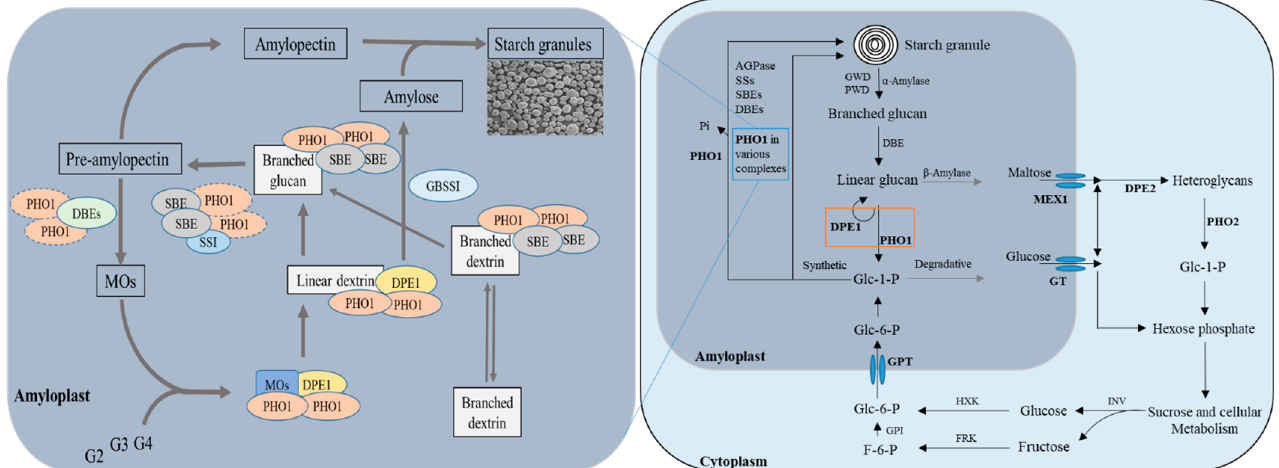
Figure 1. Putative roles of PHO1 and PHO2 in starch biosynthesis and degradation in the non-photosynthetic cell. Abbre- viations: GWD: glucan water dikinase, PWD: phospho-glucan water dikinase, DBE: debranching enzyme, DPE1, plastidial disproportionating enzyme, PHO1, plastidial starch phosphorylase, AGPase: ADP-Glc pyrophosphorylase, SSs: starch synthases, SBEs: starch branching enzymes, DPE2: cytosolic disproportionating enzymes, PHO2: cytosolic starch phos- phorylase, INV: invertase, HXK: hexose kinase, FRK: fructose kinase, GPI: glucose-6-phosphate isomerase, GT: glucose transporter, MEX1: maltose transporter, GPT: glucose-6-phosphate transporter, Pi: inorganic phosphate, Glc-1-P: glucose- 1-phosphate, Glc-6-P: glucose-6-phoshphate, F-6-P: fructose-6-phosphate and MOs: malto oligosaccharide, G2: maltose, G3: maltotriose, and G4: maltotetraose. The orange box indicates the concerted action of DPE1 and PHO1, which might define the fate of the metabolites. The trimmed MOs that are generated by the action of DBEs and PHO1 and branched oligosaccharides enter the starch biosynthetic pathway together, where they are first elongated by the concerted action of DPE1 and PHO1 metabolon, followed by the further elongation of by the SBEs and PHO1 complex. Alternatively, branched oligosaccharides are further elongated and branched by the combined action of PHO1 and isozymes of SBEs. Fusion of the generated products leads to the formation of pre-amylopectin via the possible complex of PHO1, SSs, and SBEs isozymes (still unknown). Trimming of MOs on the pre-mature amylopectin leads to its maturation that further combines with amylose (generated via the action of GBSSI) to form the starch granules. Produced from [12,17,31,36,42,50– 52].